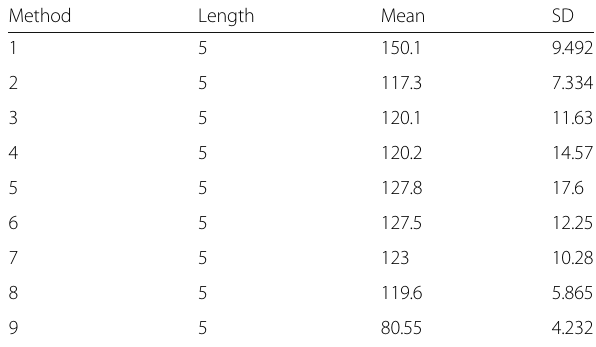
Table 2 Summarises the values for each cleaning strategy: number of observations, mean grey value and standard deviation